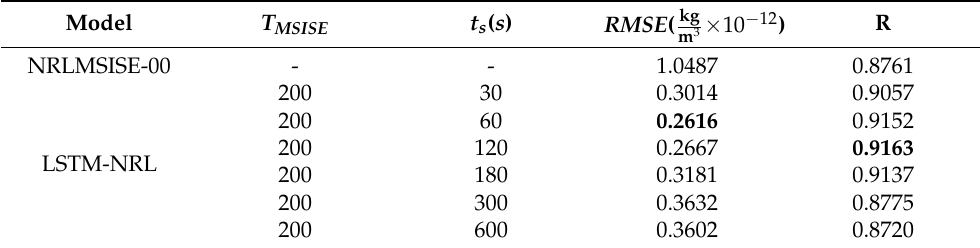
Table 3. The performance of the LSTM-NRL when changing the t s . It is noted that the best results, in terms of RMSE and R , are bold in the